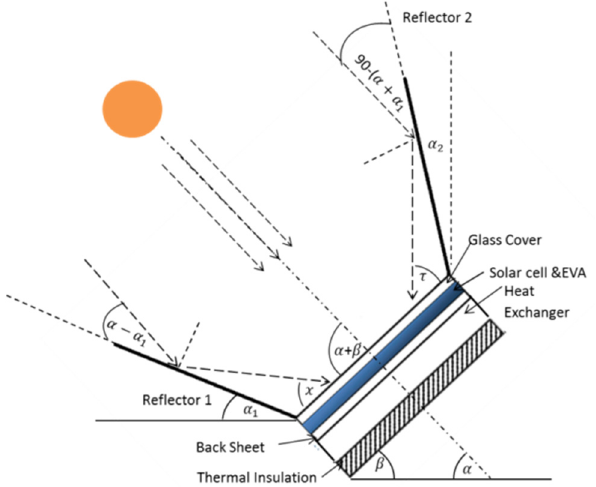
Figure 1. Schematic diagram of the V-trough PV